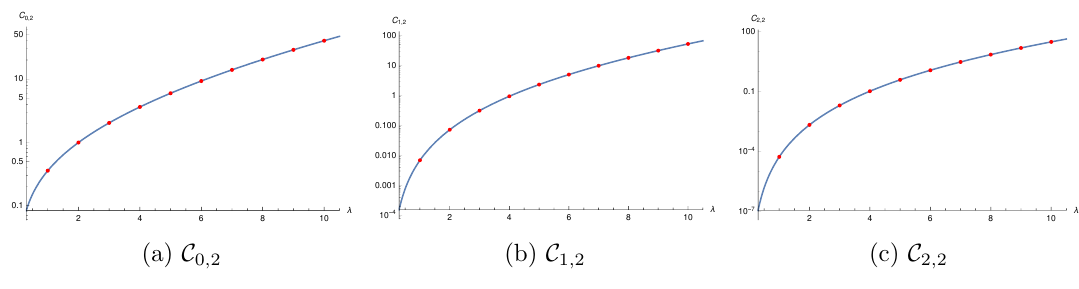
Figure 1. Plot of two-point function C g; 2 as a function of (cid:21) for (a) g = 0, (b) g = 1, and (c) g = 2. The red dots are the exact values of the right hand side of (4.5) at N = 200. The blue solid curves are the analytic result of C g; 2 obtained from the topological recursion.